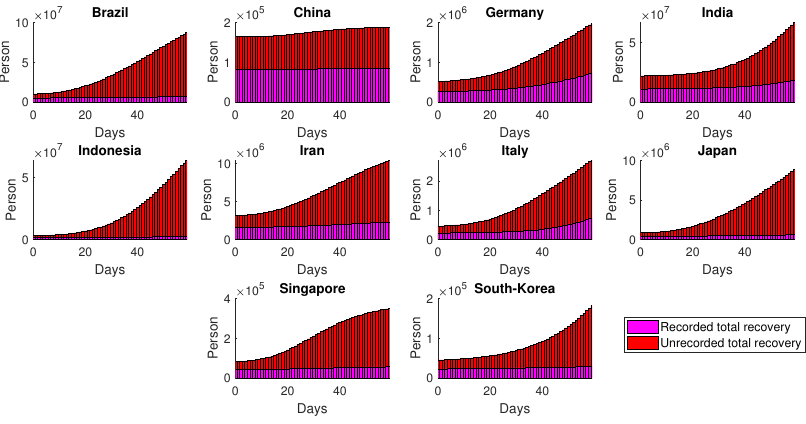
Figure 12. Dynamics of exposed and infected individuals: both recorded and unrecorded cases. Some recorded cases may not be visible due to the higher figures of exposed and unrecorded infected individuals.